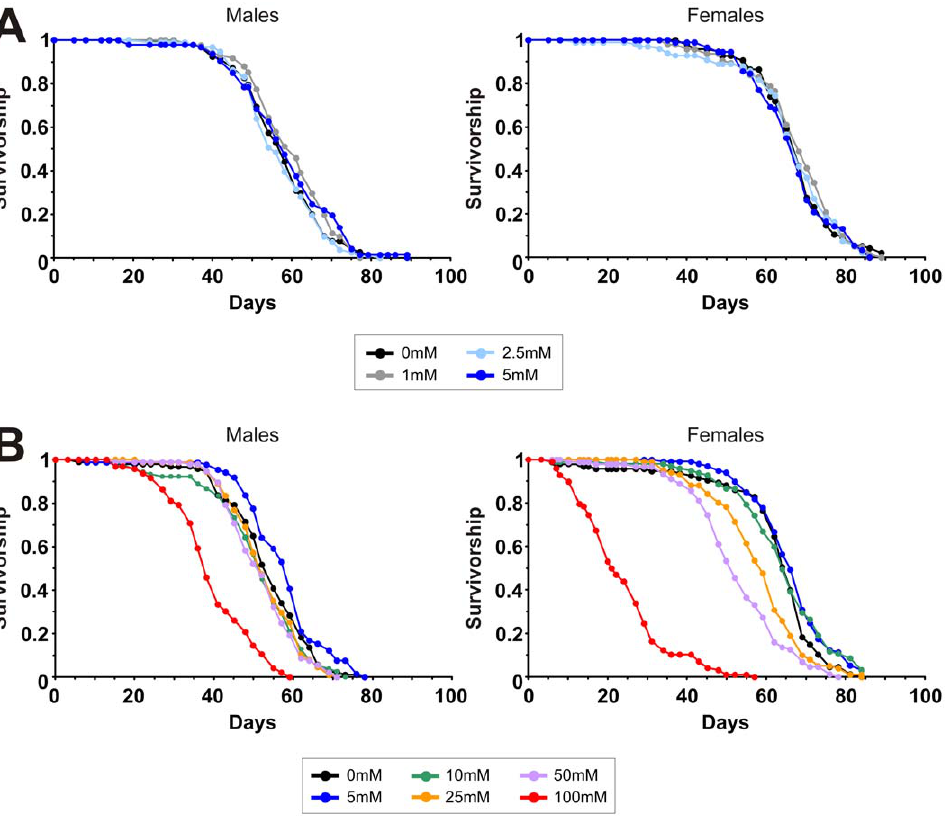
Figure 2. Metformin does not increase lifespan in Drosophila. A. Survival curves of wild-type ( Dahomey ) males and females maintained on food containing no metformin or final concentrations of 1 mM, 2.5 mM or 5 mM metformin. No significant differences in survival were observed between metformin treated flies and non-treated controls by the Log-rank test. For males, median survival times on 0 mM, 1 mM, 2.5 mM and 5 mM metformin were 57 (n=96), 59 (n=96), 55 (n=97) and 57 (n=96) days, respectively. For females, median survival times were 67 days for all conditions (0 mM n=96, 1 mM n=96, 2.5 mM n=99 and 5 mM n=91). B. Survival curves of wild-type ( Dahomey ) males and females maintained on food containing no metformin or final concentrations of 5 mM, 10 mM, 25 mM, 50 mM or 100 mM metformin. The survival curves for males maintained on 0 mM, 5 mM, 10 mM, 25 mM and 50 mM are not significantly different, while males maintained on 100 mM metformin were significantly shorter lived than non-treated controls ( P , 0.0001 by the Log-rank test). Median survival times for males on 0 mM, 5 mM, 10 mM, 25 mM, 50 mM and 100 mM metformin were 54 (n=97), 58 (n=91), 51 (n=93), 51 (n=93), 51 (n=98) and 37 (n=99) days, respectively. The survival curves for females maintained on 0 mM, 5 mM and 10 mM metformin are not significantly different. Females maintained on 25 mM, 50 mM and 100 mM metformin were significantly shorter lived than non-treated controls ( P , 0.001 by the Log-rank test). Median survival times for females on 0 mM, 5 mM, 10 mM, 25 mM, 50 mM and 100 mM metformin were 65 (n=96), 65 (n=100), 63 (n=98), 58 (n=101), 51 (n=91) and 22 (n=99) days respectively.